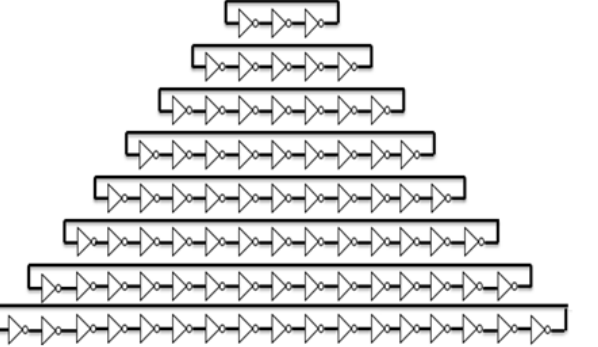
Figure 2. Entropy source of the proposed TRNG with RO-based non-identical rings.